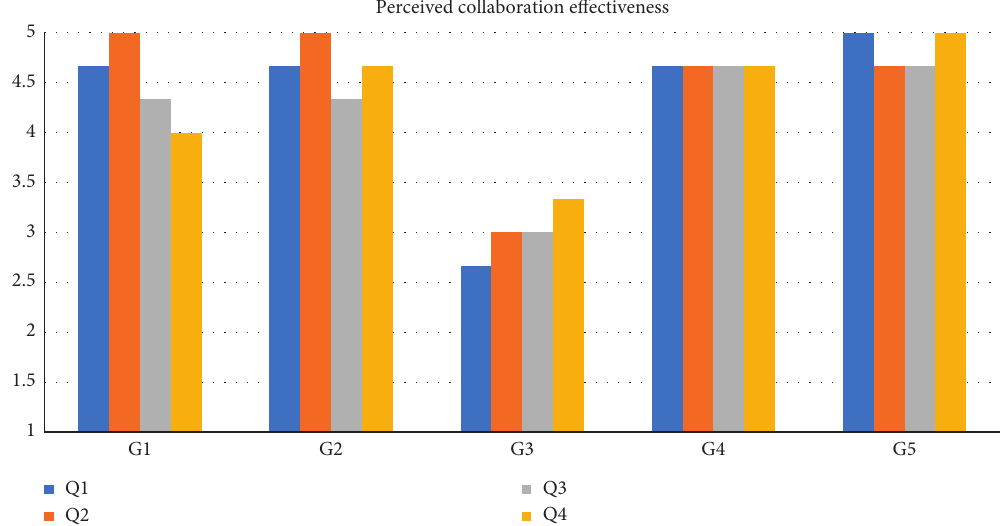
Figure 14: Perceived collaboration